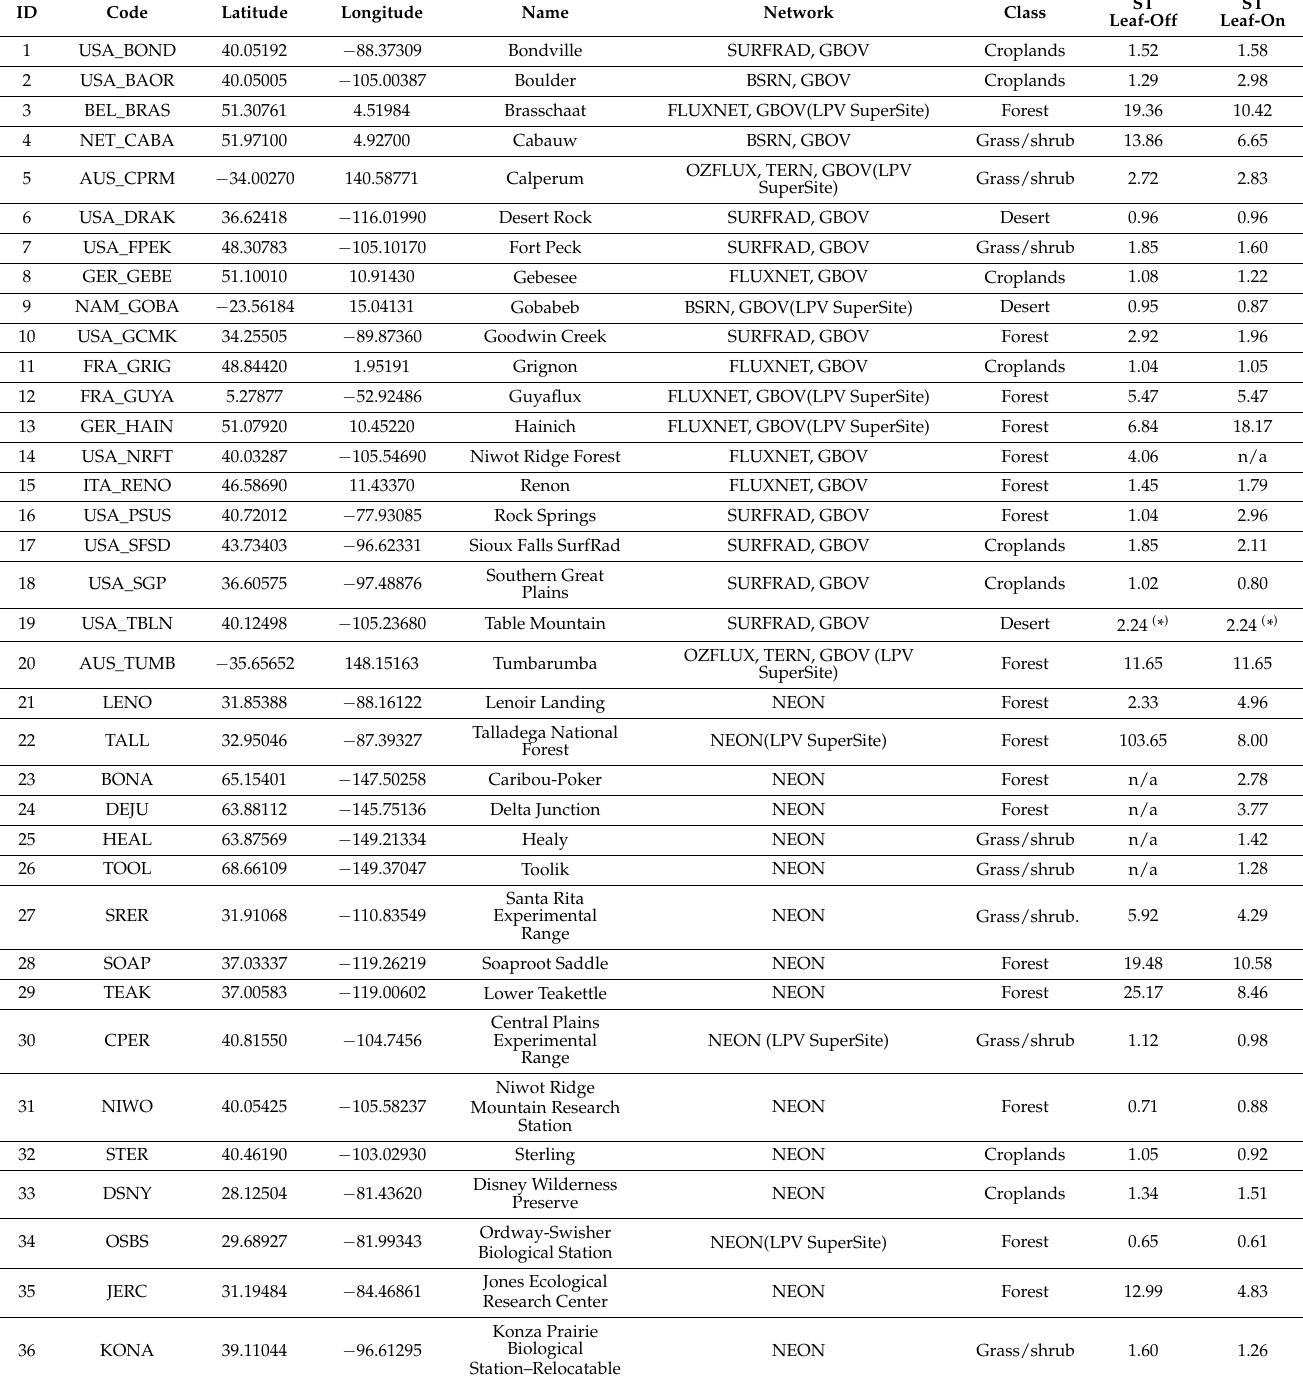
Table A1. Characteristics and ST scores of REALS